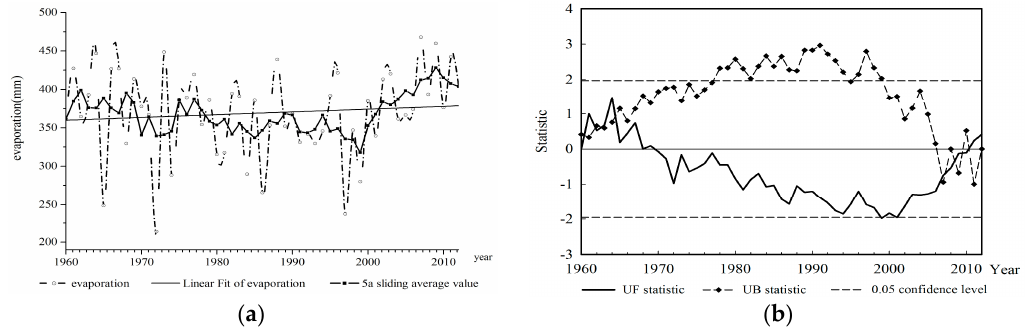
Figure 5. Annual evaporation variation trend and mutation analysis in the Jinci Spring region: ( a ) annual evaporation variation trend; ( b ) annual evaporation mutation analysis. The annual land evaporation in the Jinci Spring region varies from 213.74 to 467.9 mm, and the multi-year average value is 369.29 mm. The lowest was 213.74 mm in 1972, and the highest was 467.9 mm in 2007; the difference between them is 254.15 mm.